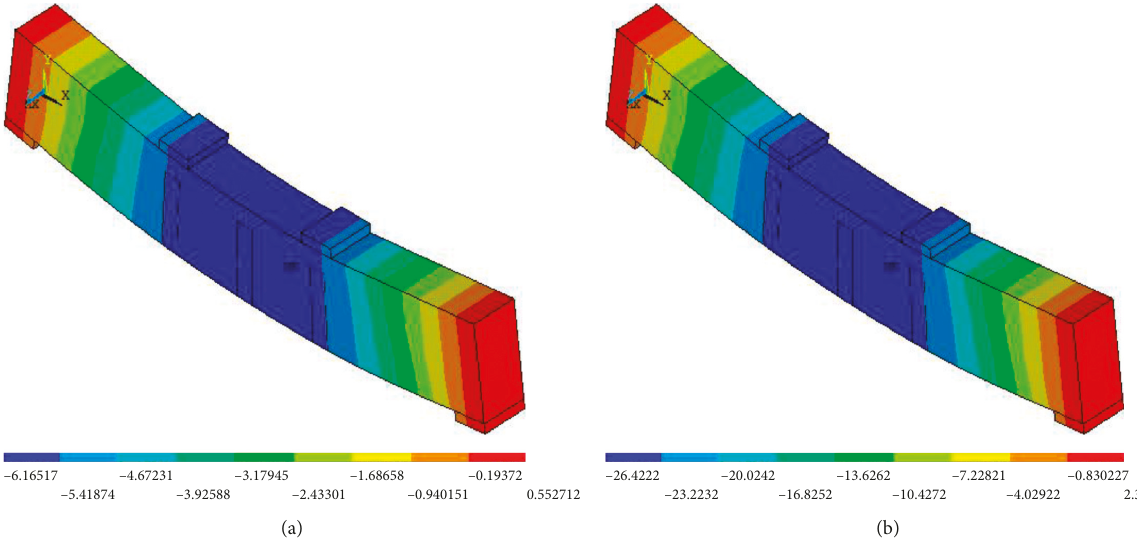
Figure 13: 3D views of deflections in the B5 model at (a) the yield load stage and (b) the maximum load